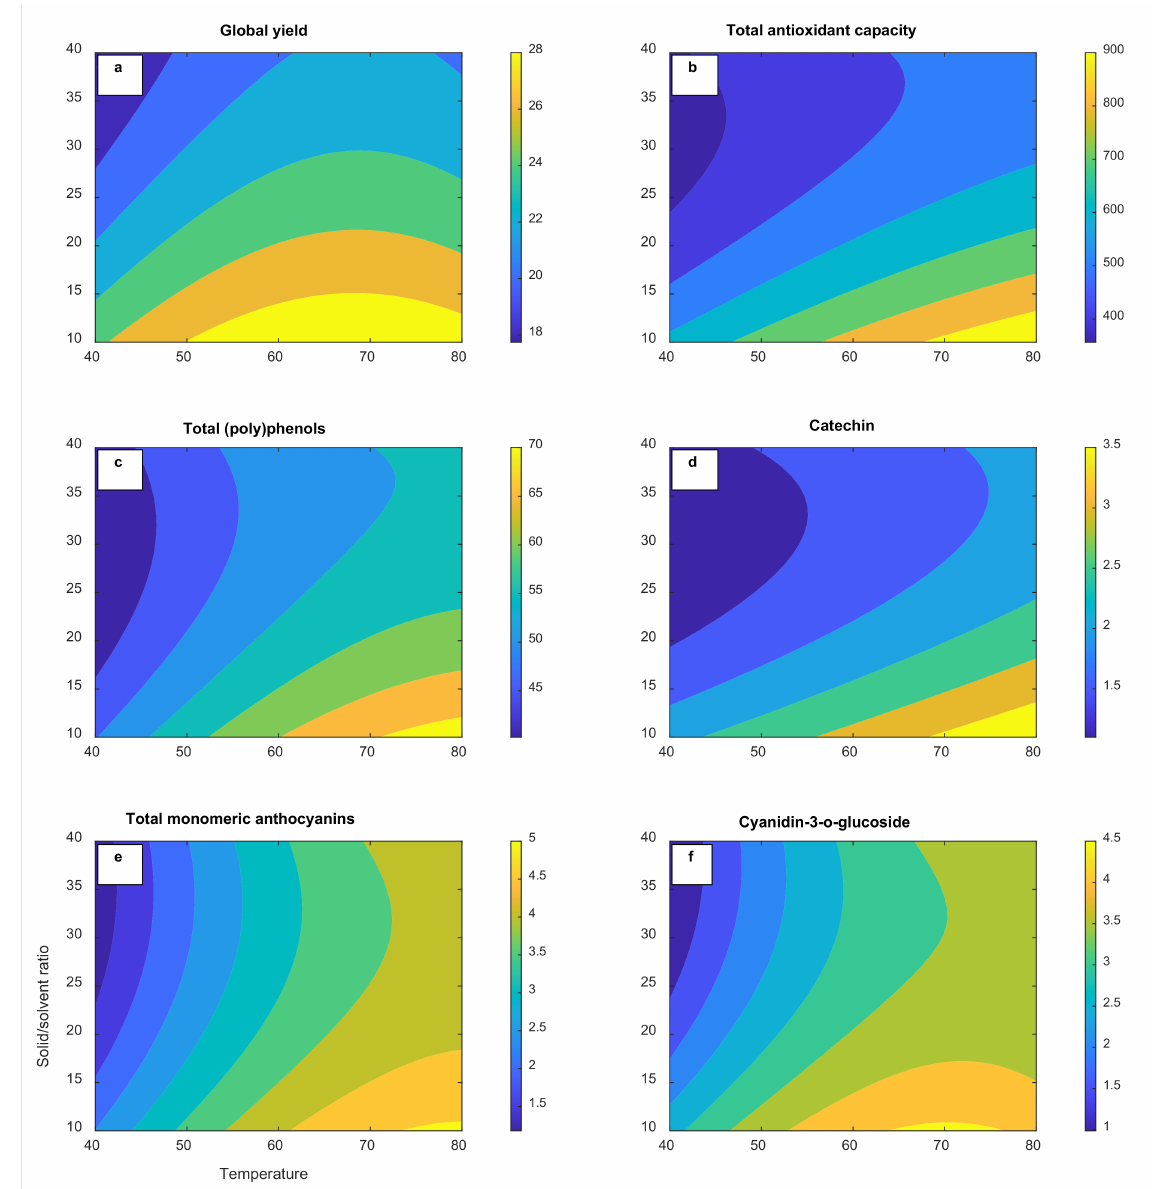
Figure 1. Response surface contour plots for PHW extract of black rosehip showing effects of interactions of temperature and solvent-to-solid ratio on ( a ) global yield (%), ( b ) total antioxidant capacity (mmol TE/g), ( c ) total (poly)phenols (mg GAE/g), ( d ) catechin (mg/g), ( e ) total monomeric anthocyanins (mg cyanidin-3- O -glucoside/g), and ( f ) cyanidin-3- O -glucoside content (mg/g), in dry